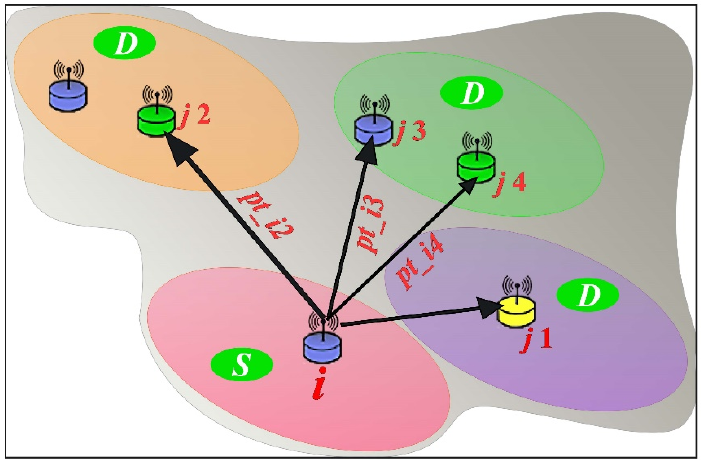
Figure 3. IoT-enabled device-to-device communication link selection mechanism.